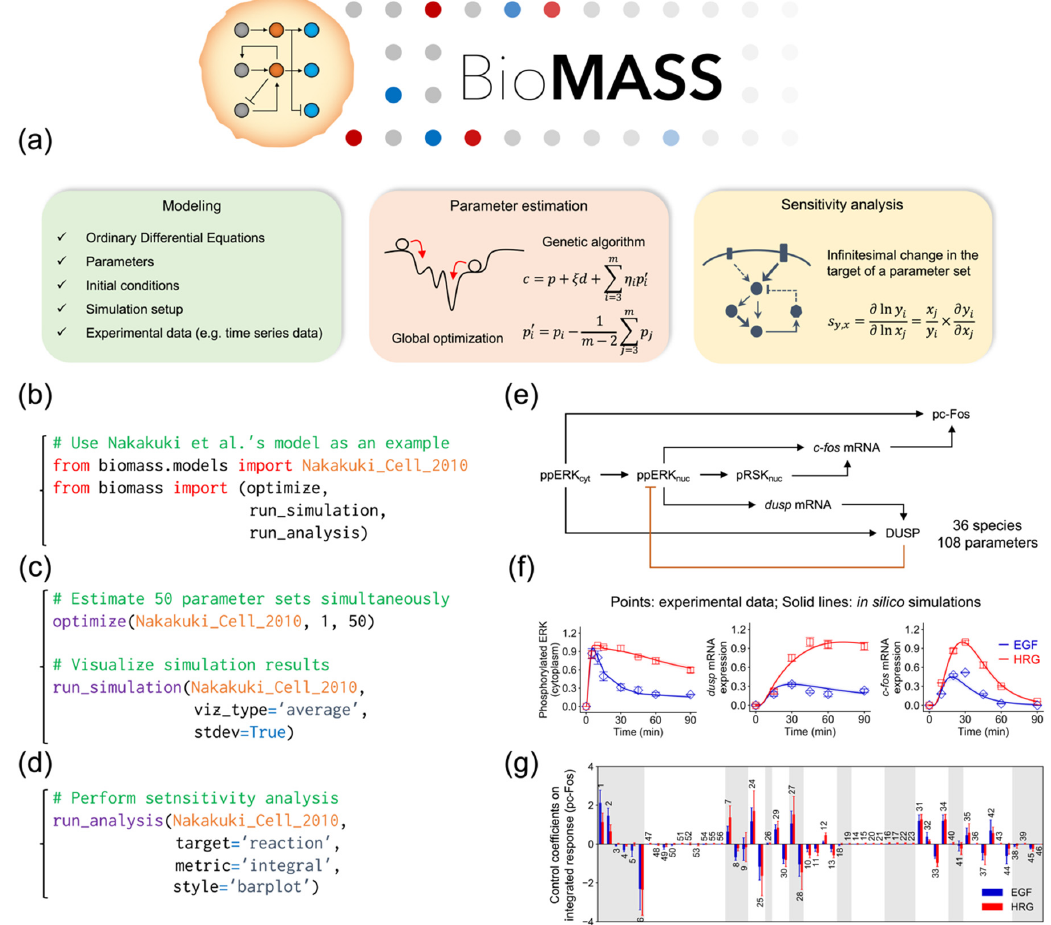
Figure 1. Overview of the BioMASS workflow. ( a ) After setting model properties (see Table 1), users can estimate unknown model parameters against experimental observations. Based on optimized parameter sets, users can perform sensitivity analysis to identify critical components or processes for cellular output. This workflow implements the model of Nakakuki et al. ( b – d ) Example code for model import ( b ), parameter estimation and visualization of simulation results ( c ) and sensitivity analysis ( d ). ( e ) Core reaction scheme of the Nakakuki model. ( f ) Simulation results using optimized parameter sets. ( g ) Output of the sensitivity analysis. Table 1. A brief description of each model file/folder in BioMASS.